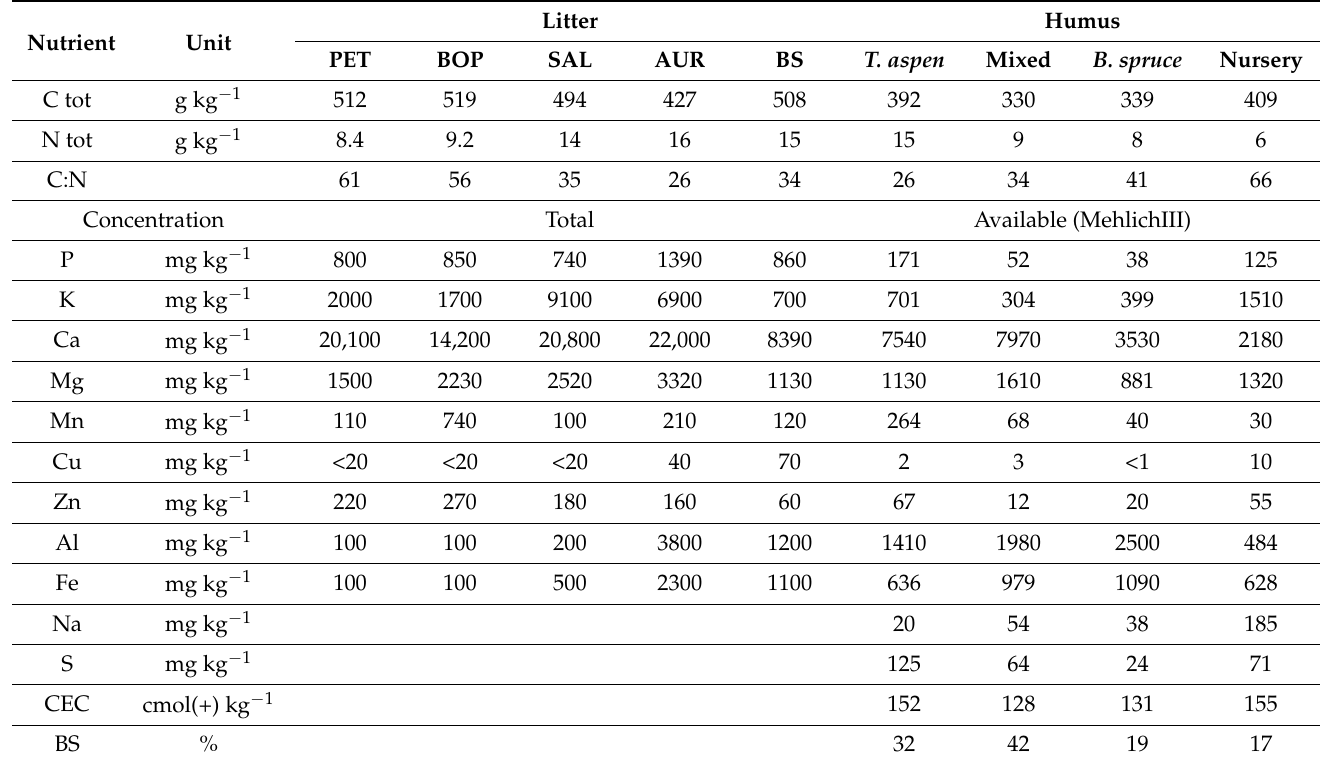
Table 2. Chemical characteristics of humus and litter before start of the greenhouse